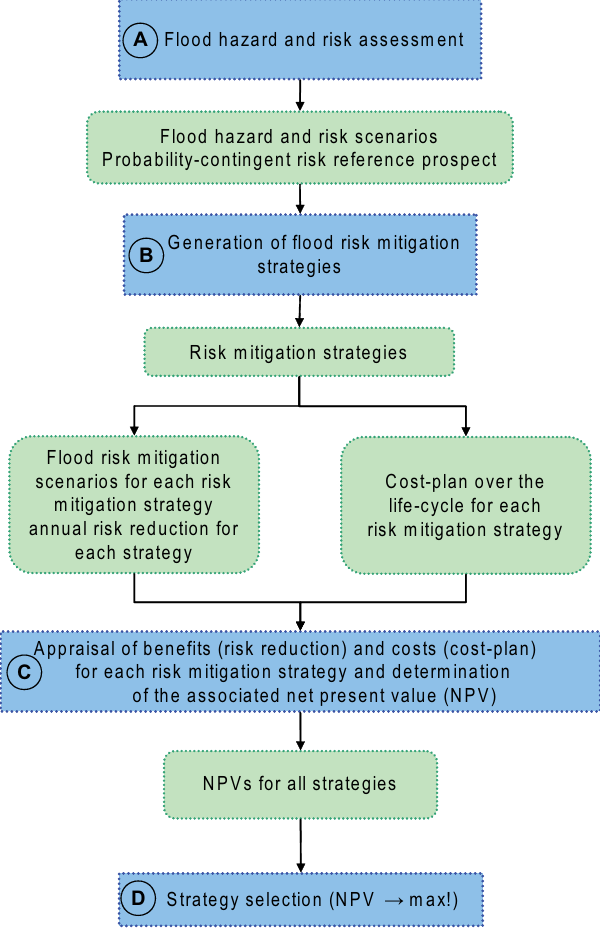
Fig. 1. Procedural roadmap for a comprehensive risk mitigation project assessment based on the concept of Net Present Value (NPV); A, B, C, D: